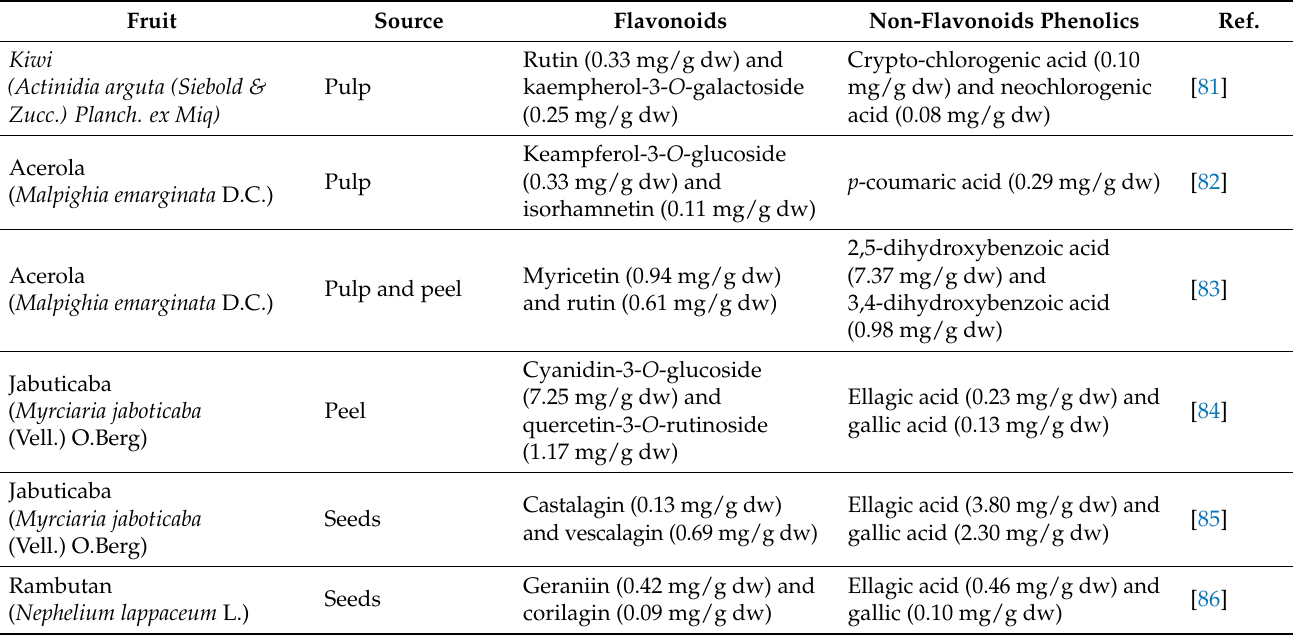
Table 1. Flavonoid and non-flavonoid phenolic compounds found in edible and non-edible parts of several tropical fruits. Fruit Source Flavonoids Non-Flavonoids Phenolics